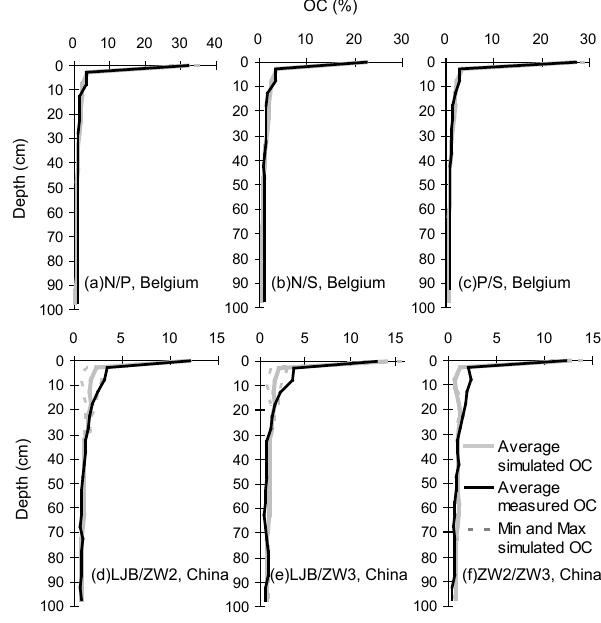
Fig. 5. Comparison of vertical distribution of simulated vs. mea- sured OC content in soil pedons. (a) N/P pedons in Belgium; (b) N/S pedons in Belgium; (c) P/S pedons in Belgium; (d) LJB/ZW2 pedons in China; (e) LJB/ZW3 pedons in China; (f) ZW2/ZW3 pe- dons in China. Min is minimal value while Max is maximal